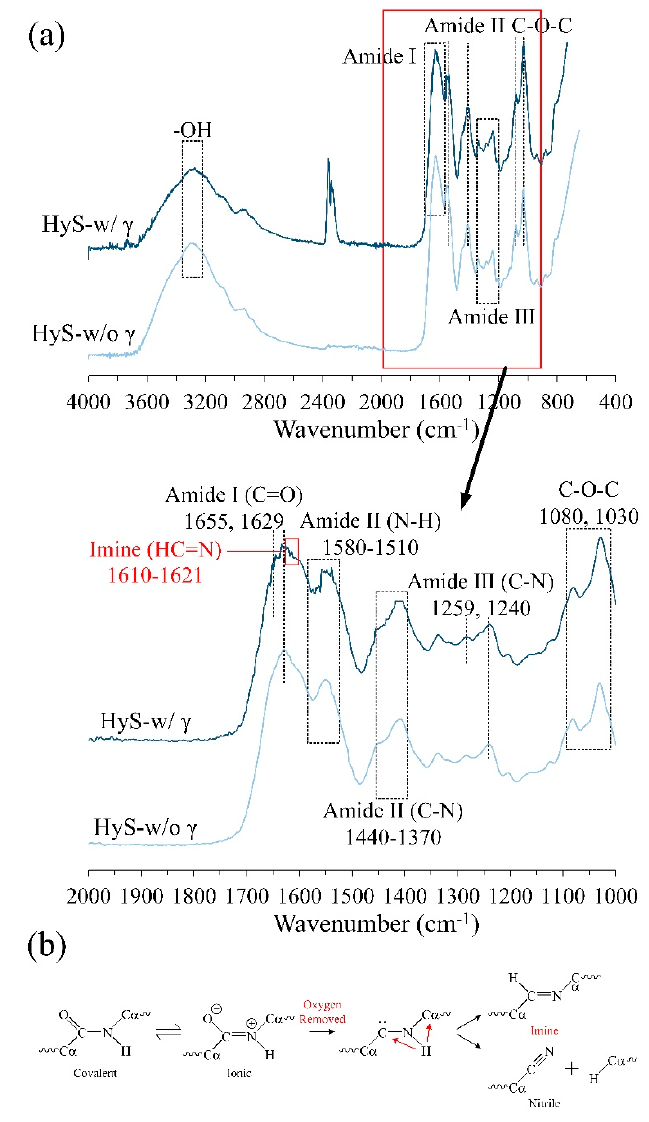
Figure 3. ( a ) Full and specific absorption bands obtained through the FTIR spectrum analysis of macrospheres before (HyS-w/o γ ) and after (HyS-w/ γ ) sterilization. ( b ) Schematic of the mechanisms of amide bond decomposition into active imine or nitrile groups after irradiation, which can generate new intermolecular crosslinking sites in hydrogels.